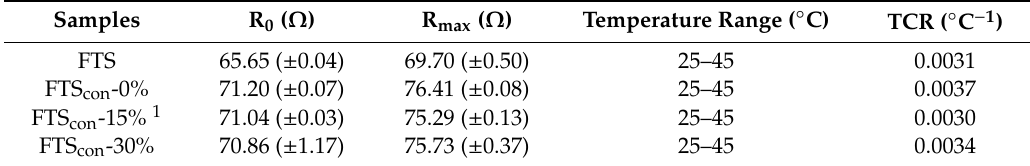
Table 1. Electrical resistance and TCR of one fabric temperature sensor.